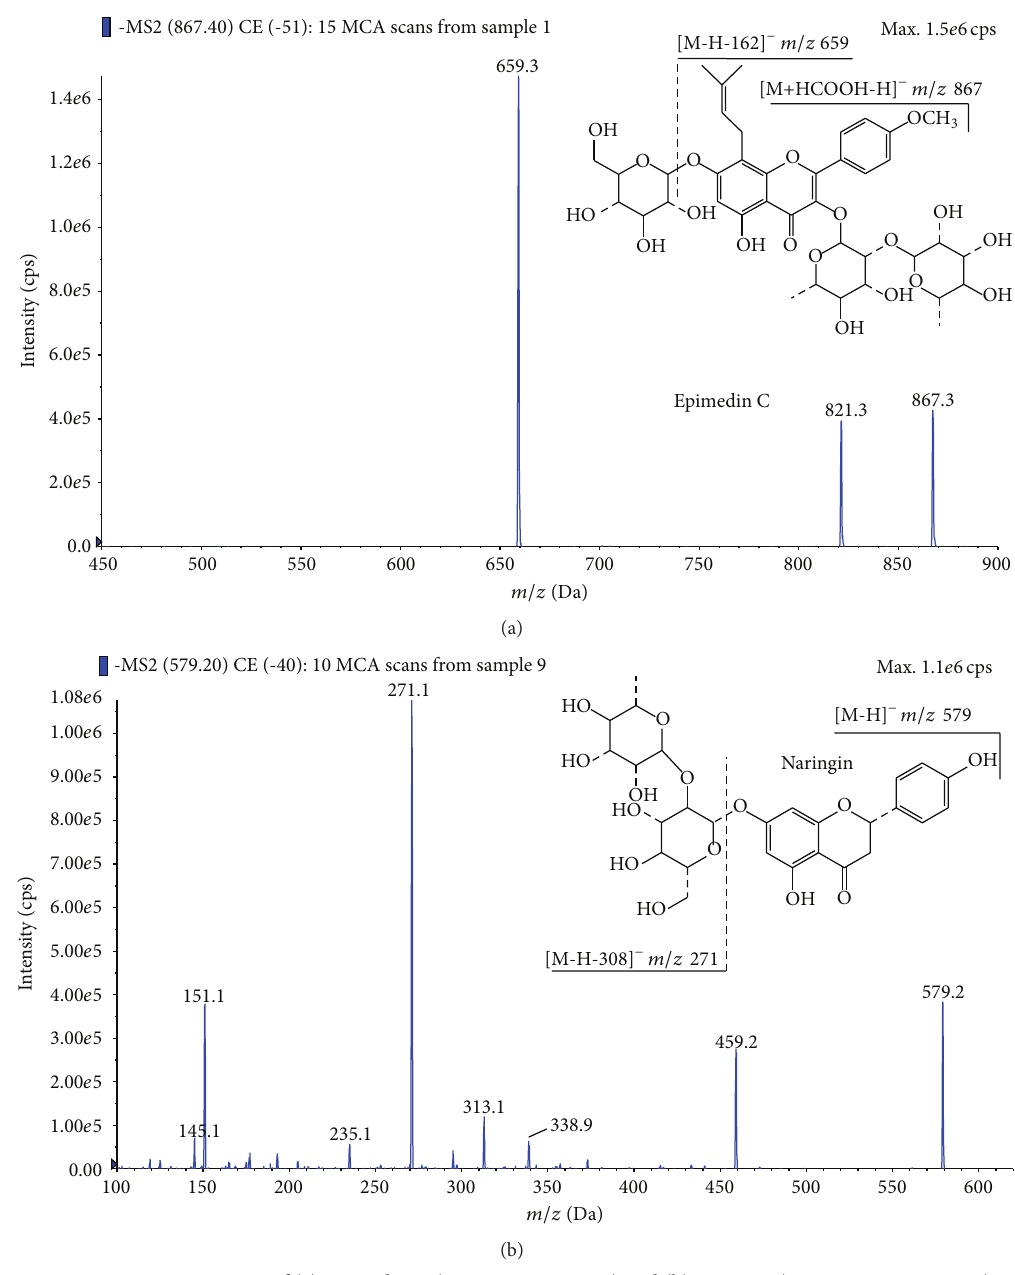
Figure 3: MS/MS spectra of (a) epimedin C ( m/z 867.3 → 659.3 ) and (b) naringin (IS, m/z 579.2 → 271.1 ). concentration-time curve. All data were analyzed by DAS Software (ver. 2.0, China State Drug